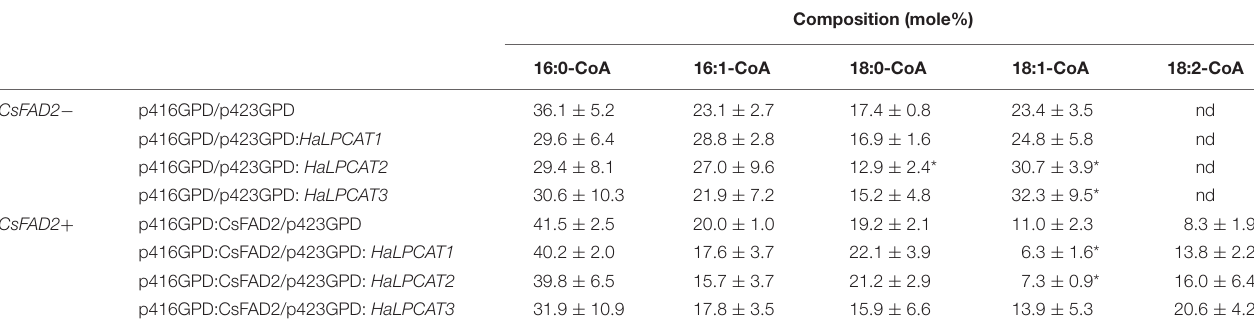
TABLE 3 | Fatty acyl composition of the acyl-CoA pool of Saccharomyces cerevisiae strain Y02431 ( slc4 (cid:49) ) mutant expressing LPCATs from sunflower in the presence or absence of expression of a Camelina sativa FATTY ACID DESATURASE 2 ( CsFAD2